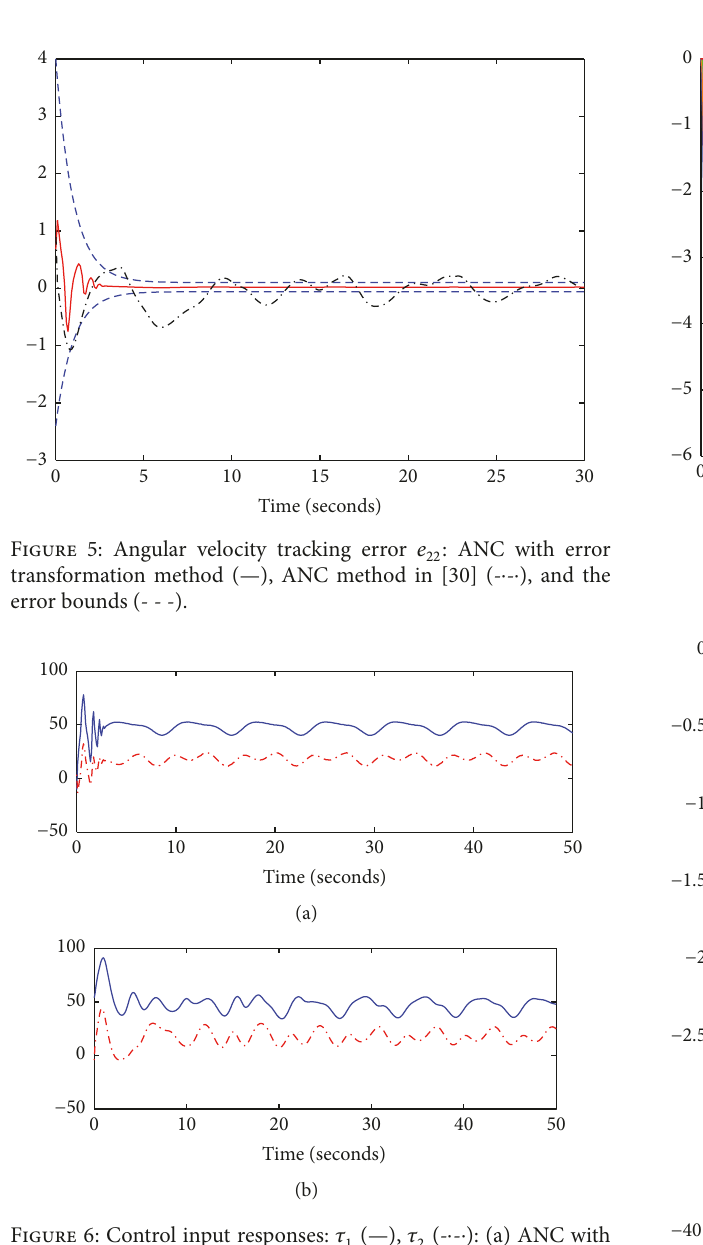
Figure 6: Control input responses: 𝜏 1 (—), 𝜏 2 (- ⋅ - ⋅ ): (a) ANC with error transformation and (b) ANC in [30].